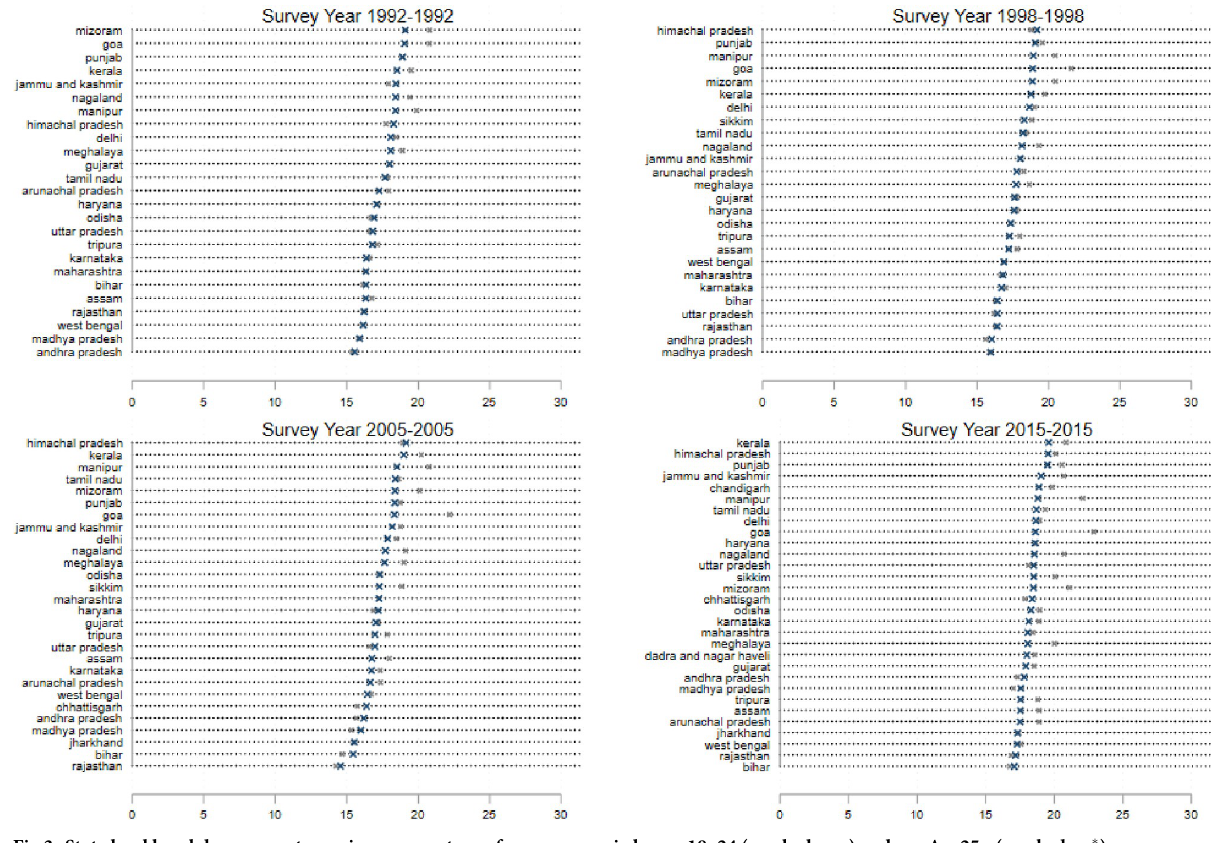
Fig 3. State level breakdown; age at marriage; percentage of women married, ages 18–24 (marked as × ) and age Age25+ (marked as � ).